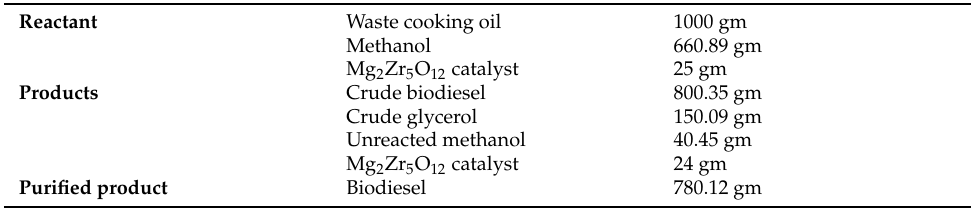
Table 6. Mass calculation for biodiesel production